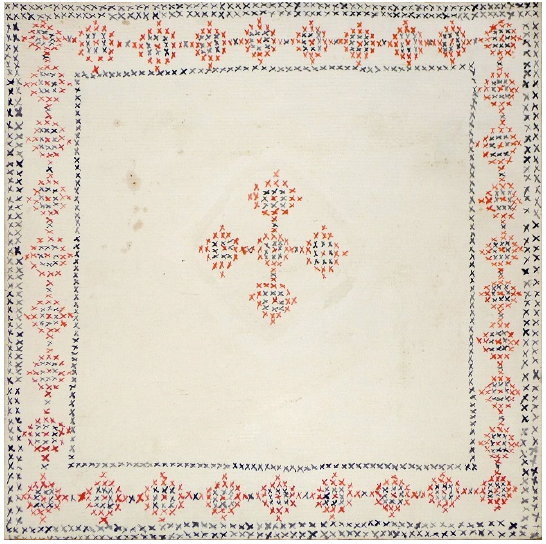
Figure 21. Stolpovskaya. Cross-stitched Headscarf. 1980. Canvas, oil. 69.5 cm. × 69.5 cm. Courtesy of the artist.